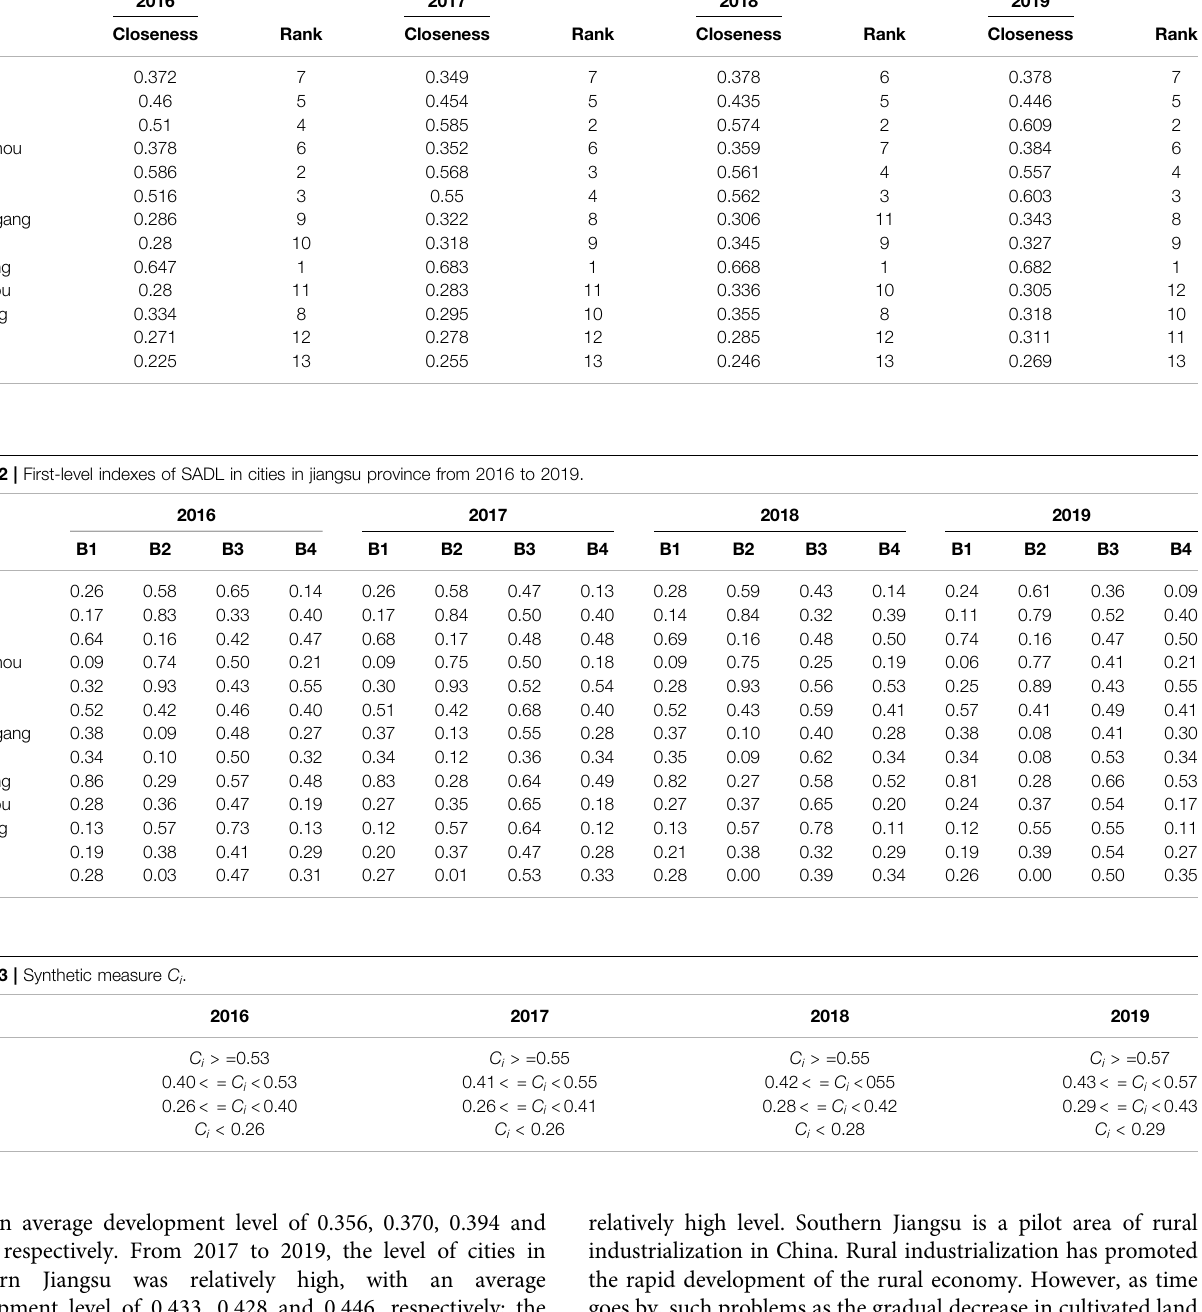
TABLE 1 | SADL in cities in jiangsu province from 2016 to 2019. City